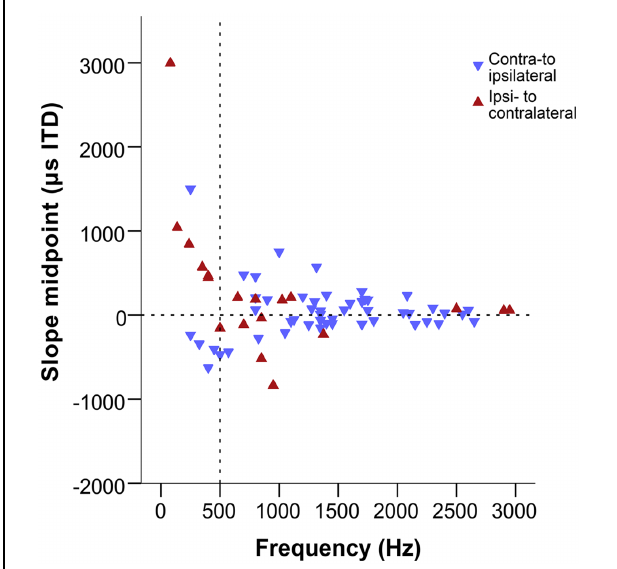
FIGURE 8 | Slope midpoints of the ITD-response functions from the combined data of this study and Köppl and Carr (2008). Negative values represent ipsilateral-leading sounds and positive values represent contralateral-leading sounds. Red triangles represent ipsi- to contralateral downward slopes, blue triangles represent contra-to ipsilateral downward slopes, i.e., both types of triangles point in the downward direction of the slope. The horizontal dashed line marks the acoustic midline at 0 µ s ITD and the vertical dashed line marks the 500 Hz position.